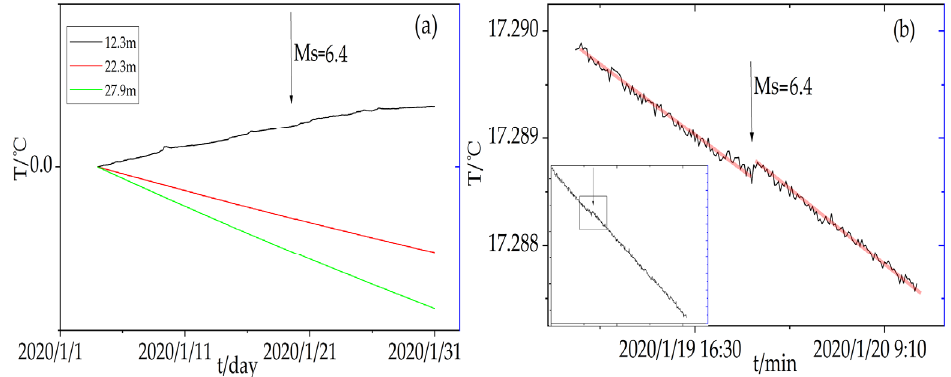
Figure 4. ( a ) Ground temperature changes in different layers at the JSZC ground temperature observation station. ( b ) Time series of ground temperature in the 22.3 m layer of JSZC.